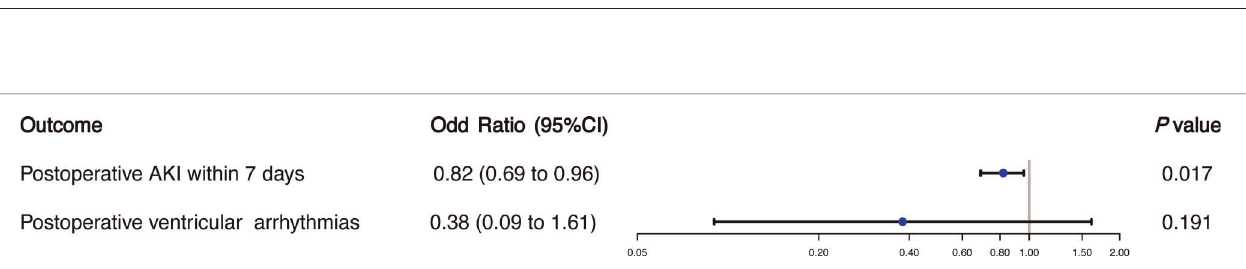
FIGURE 2 | Ondansetron exposure in the fi rst 48 h after cardiac surgery and 90-day mortality. The primary outcome analysis was performing with three different models: (1) multivariable logistic regression; (2) inverse probability of treatment weighting; and (3) covariate balancing propensity score.